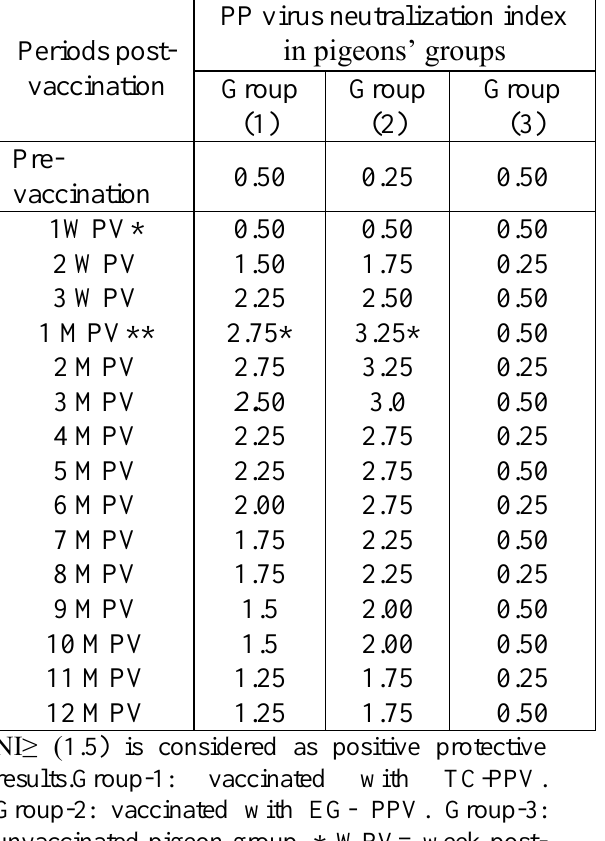
Table 3: Virus Neutralization Index in vaccinated pigeons with TC-PPV and EG-PPV: Periods post- vaccination Pre- vaccination